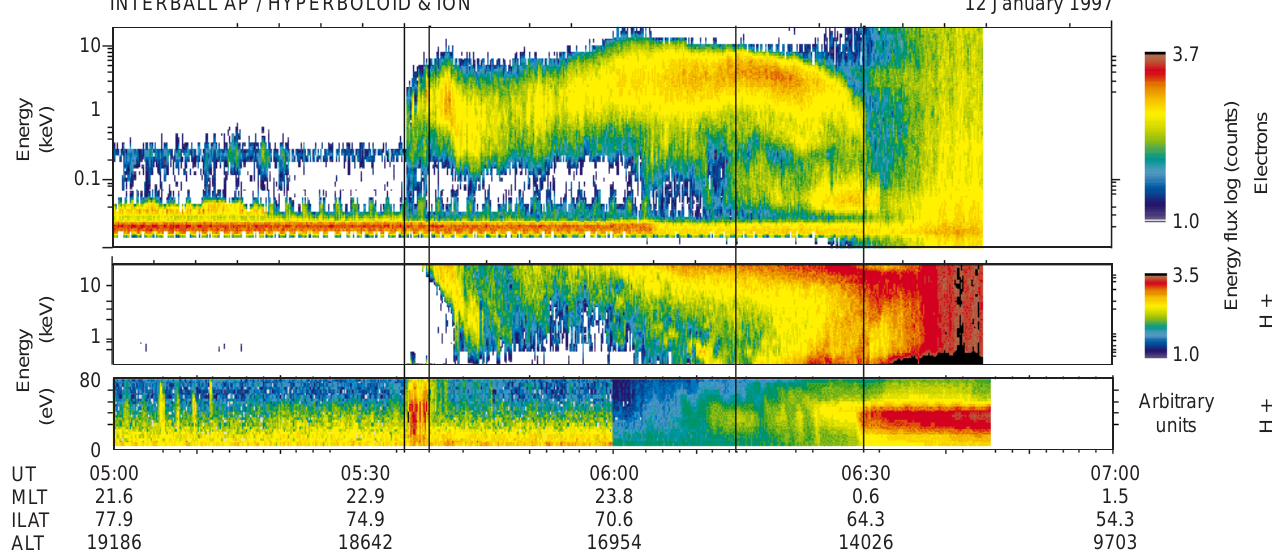
Fig. 7. From top to bottom, energy-time spectrograms for high- energy electrons and H + ions from Ion, and for 0–80 eV H + ions from Hyperboloid between 05:00 and 07:00 UT on 12 January 1997.